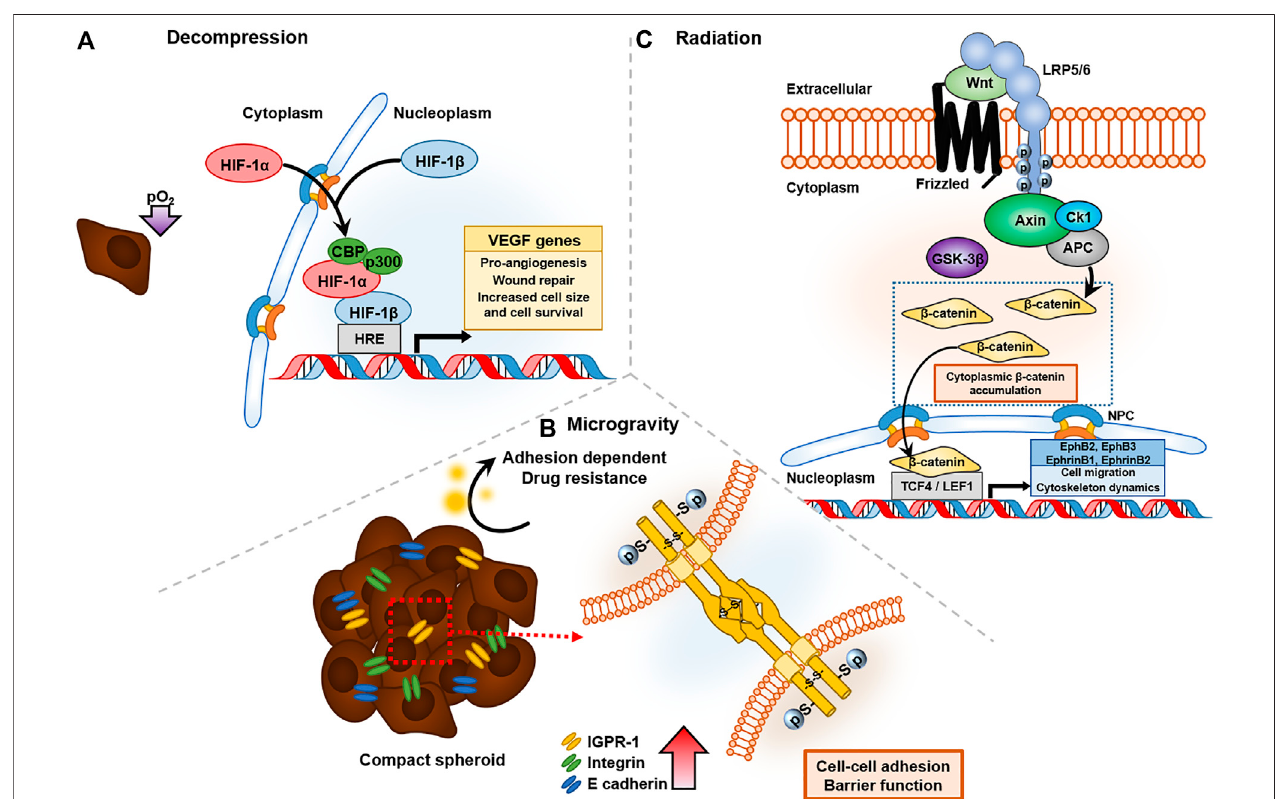
FIGURE3| Canceraffectedbythreerepresentative altered environmental conditionsinspace:decompression,radiation, and microgravity. (A) Decompression of oxygen activates HIF-1 α expression and forms a DNA binding complex with CBP/p300 to VEGF gene transcripts, which have pro-angiogenesis and wound-repair functions. (B) Microgravity upregulated the expression of cell-to-cell junction proteins, such as IGPR-1 and E-cadhrin, which have barrier functions in drug resistance. (C) Radiation in space triggers the Wnt signaling pathway, and accumulated β -catenin bind to T-cell factor/lymphoid enhancer factor family (TCF/ LEF), leading to transcription of EphB/EphrinB, which regulates cell migration and cytoskeletal dynamics.